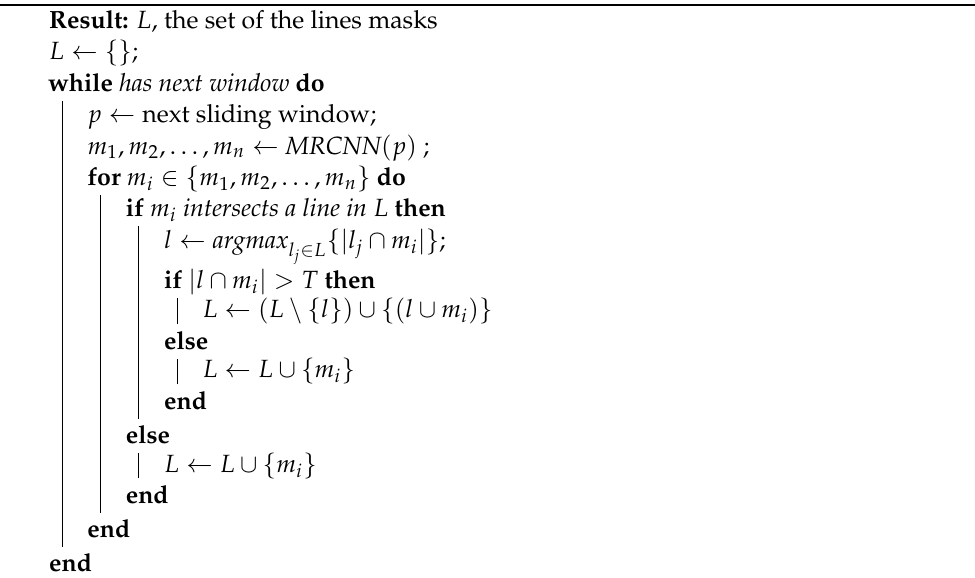
Algorithm 1: Page segmentation method using Mask